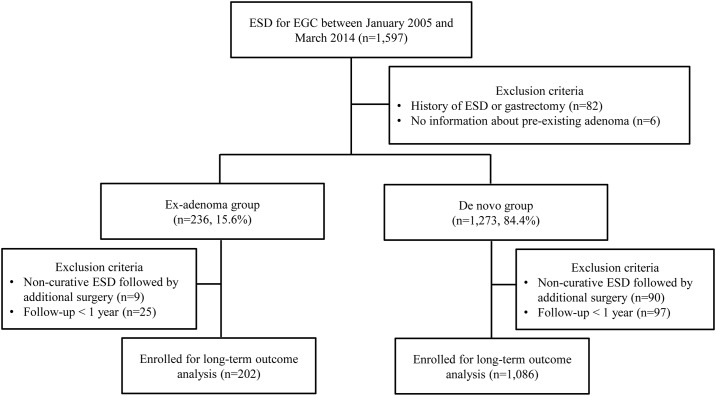
Schematic protocol of this study.